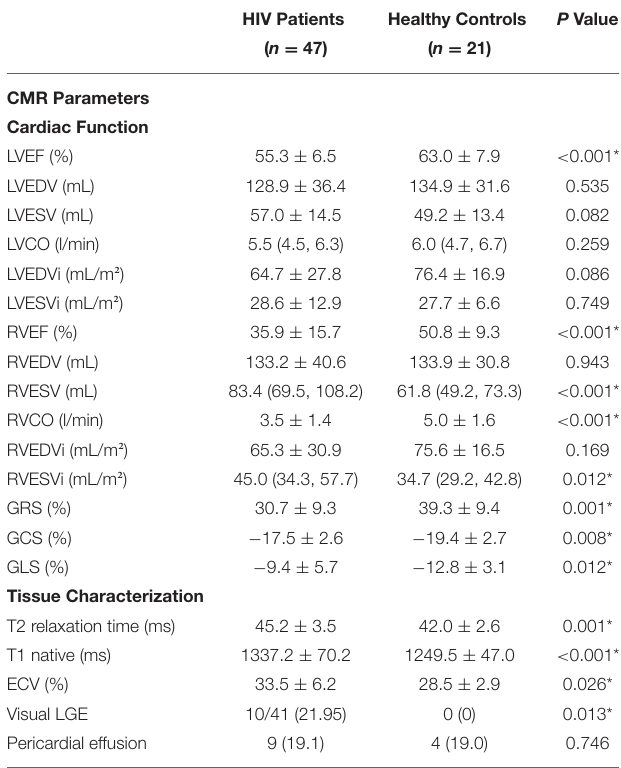
TABLE 1 | CMR characteristics of HIV patients and healthy